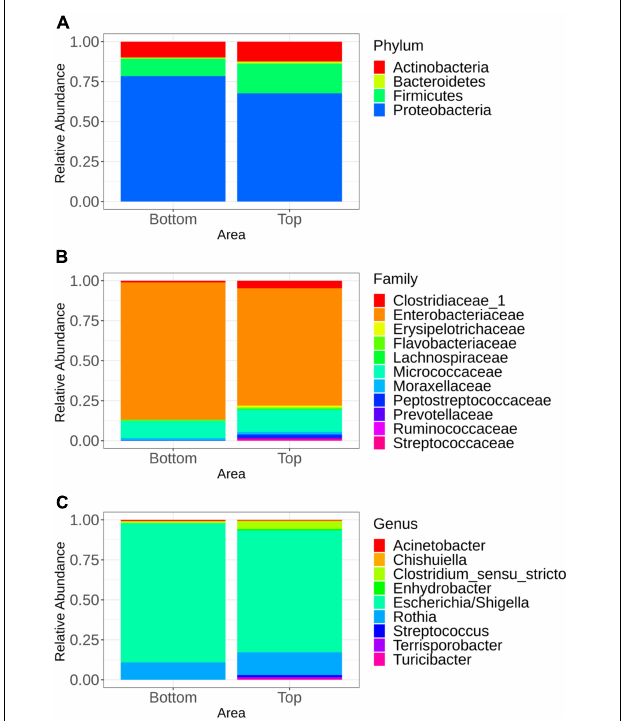
FIGURE 3 | Mean relative abundance of the major bacterial groups at the phylum level (A) , family level (B) , and genus level (C) identified in samples representing the top and bottom areas of the pig carcasses. Only bacterial communities representing at least 5% of carcass surface microbiota are